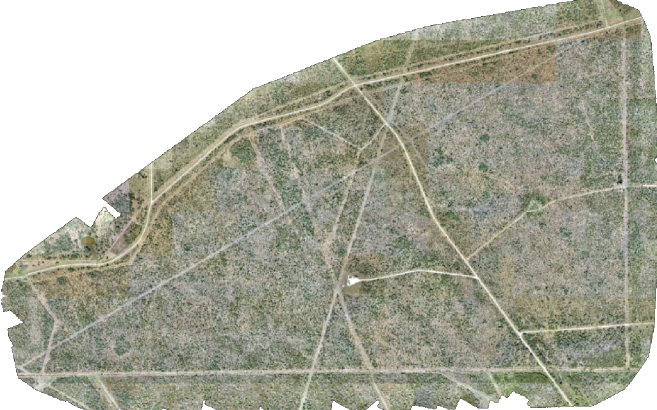
Figure 4. Orthomosaic image of 600+ acre grazing paddock at Welder Wildlife Foundation taken in December 2015 with the eBee fixed-wing platform and RGB camera.